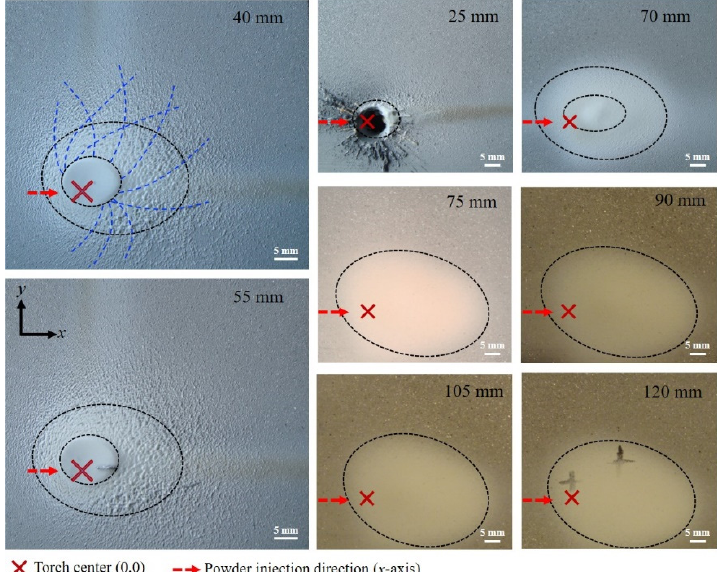
Figure 2. Photographs showing the morphology and off-axis displacement of static footprints respective to plasma torch axis as a function of stand-off distance.